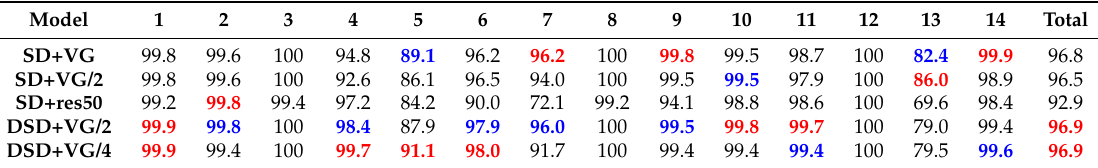
Table 2. Mean of average precision (mAP) of facility detection (%). Red and blue numbers are the best and second probabilities in each column, respectively.